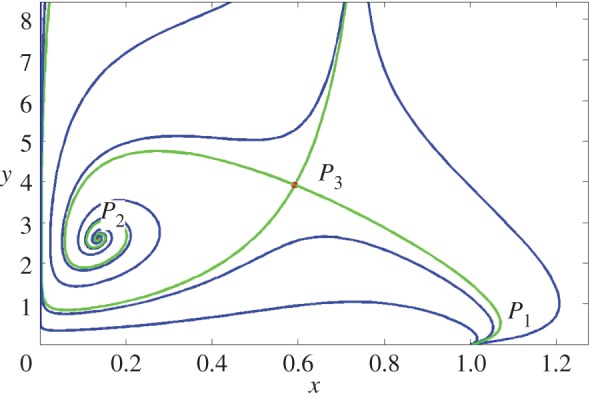
The equilibria of system (2.3). P1 and P2 are stable, whereas P3 is a saddle point. It is worth noting P1 is a node and P2 could be a node or a focus, depending on the parameter values. The heteroclinic trajectory joining the saddle point to the stable node is easily identified. The stable manifold is a separatrix between the basin of attraction of P1 and P2. The following parameters were used: k=0.8, b=0.6, c=0.3, e=0.05 and f=2.